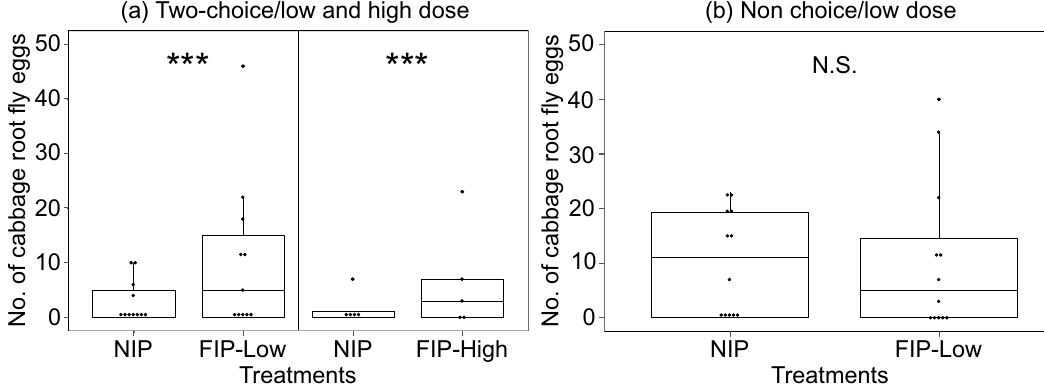
Figure 6. Symmetrical dot-density plot with superimposed box plot showing the distribution of the total